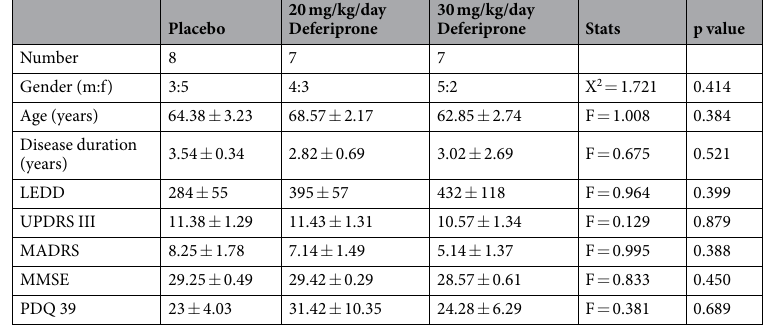
Table 1. Demographic data of Parkinson’s disease patients. Values are represented as mean ±